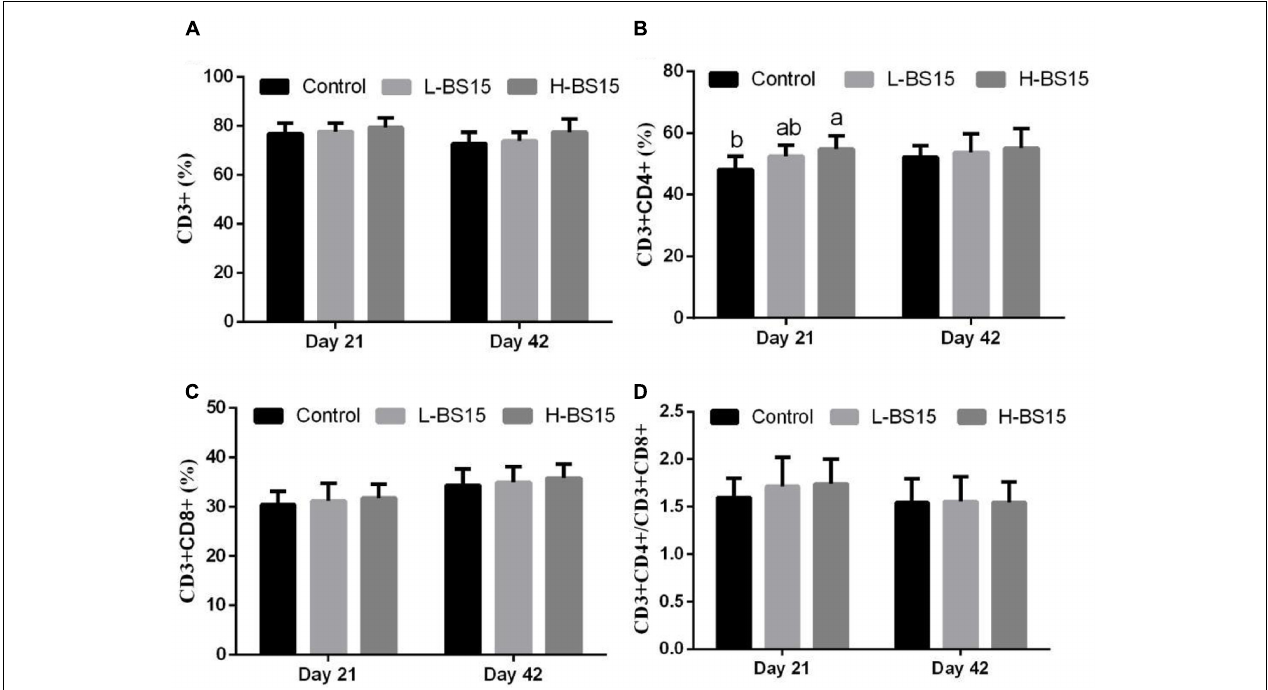
FIGURE 6 | CD3 + (A) , CD3 + CD4 + (B) , CD3 + CD8 + (C) , T-lymphocyte percentages and CD3 + CD4 + /CD3 + CD8 + ratio (D) in the peripheral blood at days 21 and 42 (Experiment 1). Bars with different letters are significantly different on the basis of Duncan’s multiple range tests ( P < 0.05). Data are presented as mean ± standard deviation (six replicates of one chick per cage).